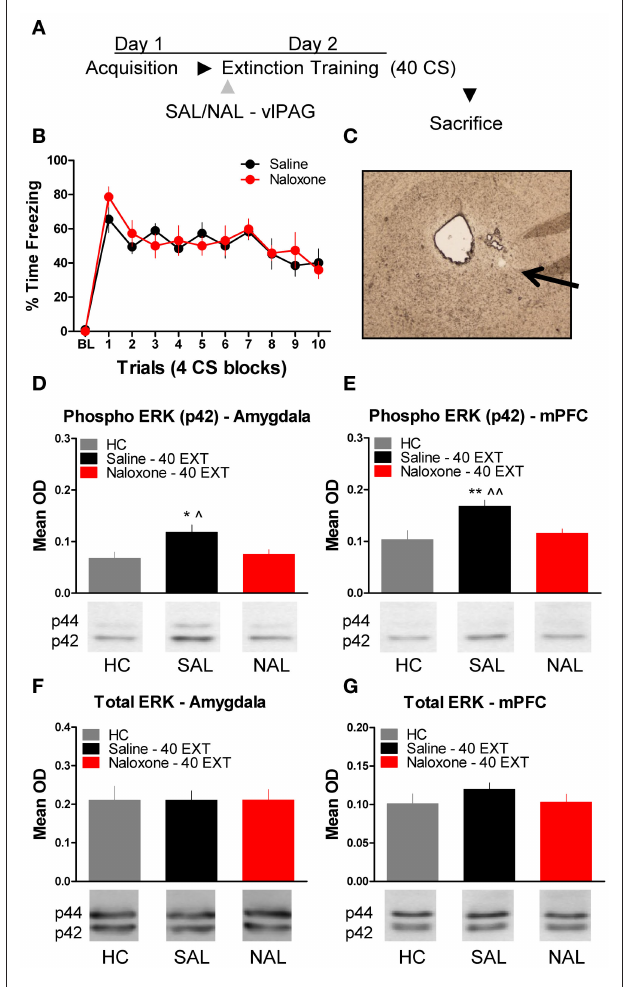
Figure 4 | extracellular-related kinase phosphorylation following extinction training is blocked by opioid receptor antagonism in the vlPAg. (A) Schematic showing the behavioral procedures used in this experiment. (B) Freezing to the CS during the extinction training session. (C) Representative image taken using Nomarski optics at 10 × . Arrow indicates the approximate infusion site in the vlPAG. Expression of phosphorylated ERK in the amygdala (D) and mPFC (e) of rats infused with saline ( N = 9, black) or naloxone ( N = 9) and given extinction training. HC rats ( N = 6, gray) were trained, but sacrificed from their home cage. Total ERK levels in the amygdala (F) and mPFC (g) in the same rats. (* p < 0.05 relative to HC; ** p < 0.01 relative to HC; ^ p < 0.05 relative to Naloxone 40 EXT; ^^ p < 0.01 relative to Naloxone 40